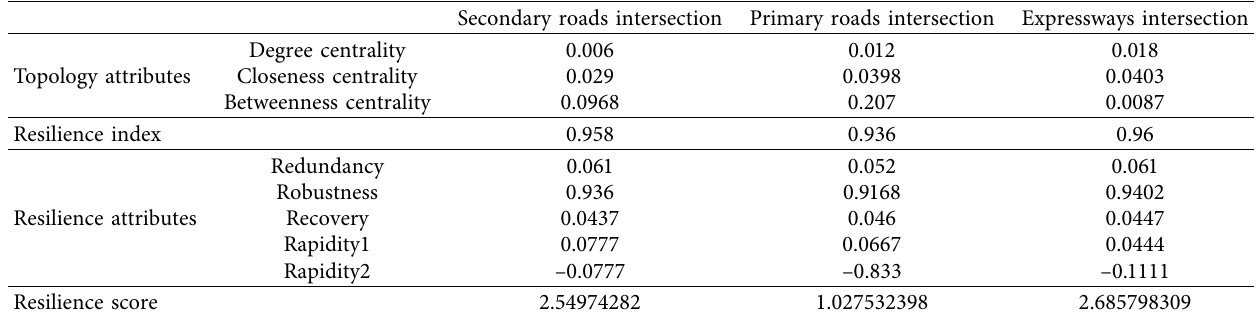
Table 3: Resilience score for three scenarios of malignant traffic